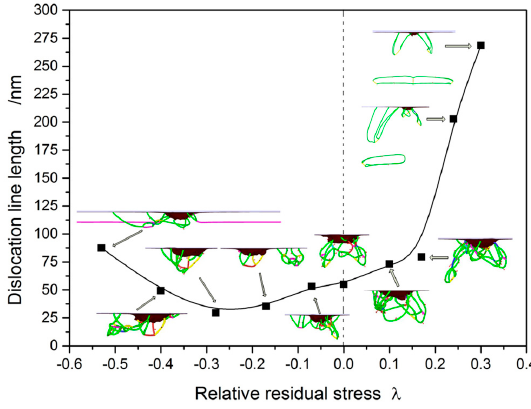
Figure 13. Dislocation line length in Cu samples with different residual stresses.